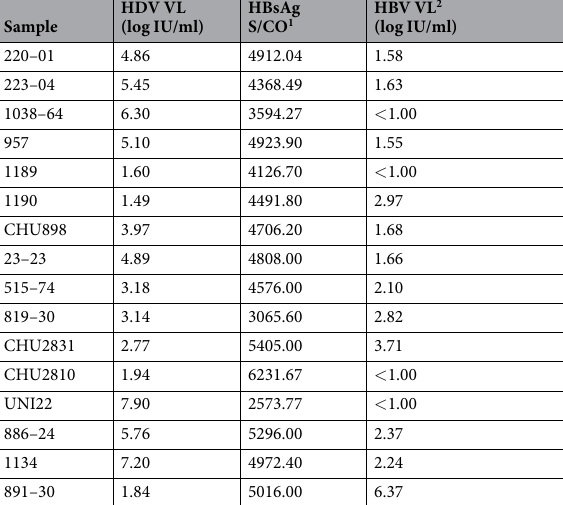
Table 3. HDV RNA positive samples from Cameroon. 1 S/CO ≥ 1.00 is considered positive. Determined using the ARCHITECT HBsAg (1L80) or ARCHITECT HBsAg Qualitative (4P53) assays (Abbott Diagnostics, Abbott Park, IL). 2 HBV viral load determined using the RealTi m e HBV viral load assay (Abbott Molecular Diagnostics, Des Plaines,